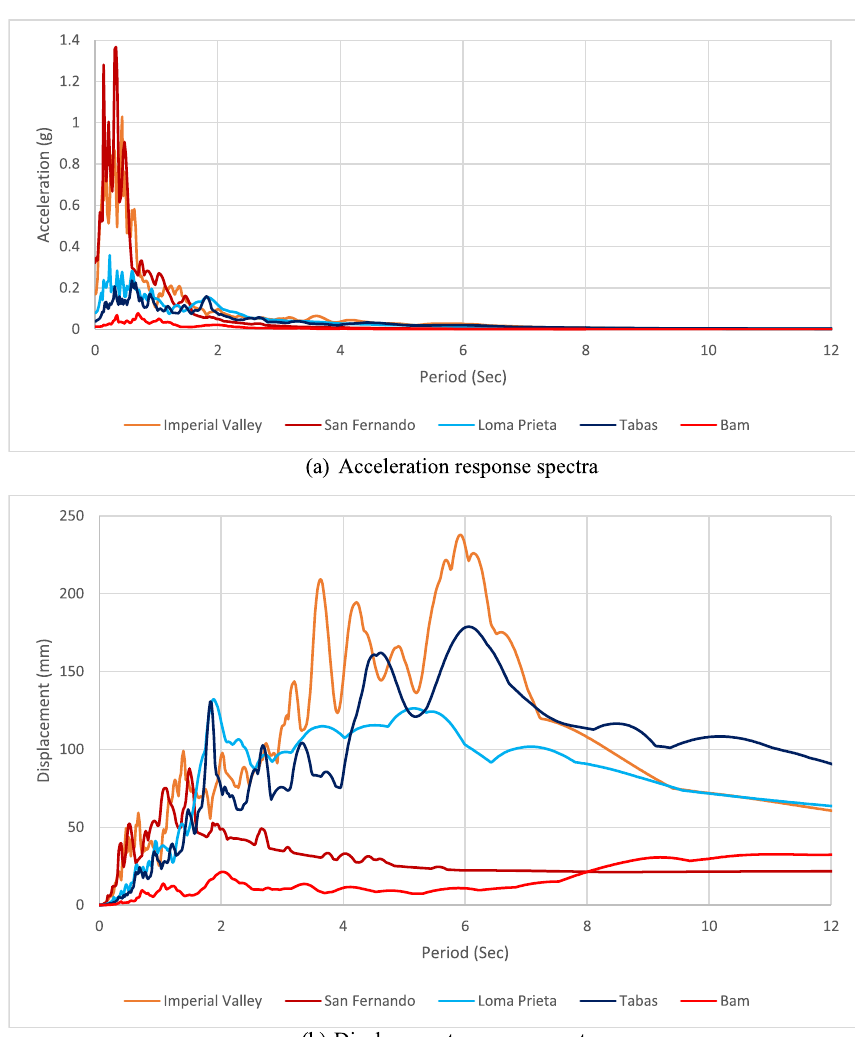
Fig. 7 Response spectra of utilized earthquakes. a Acceleration response spectra. b Displacement response